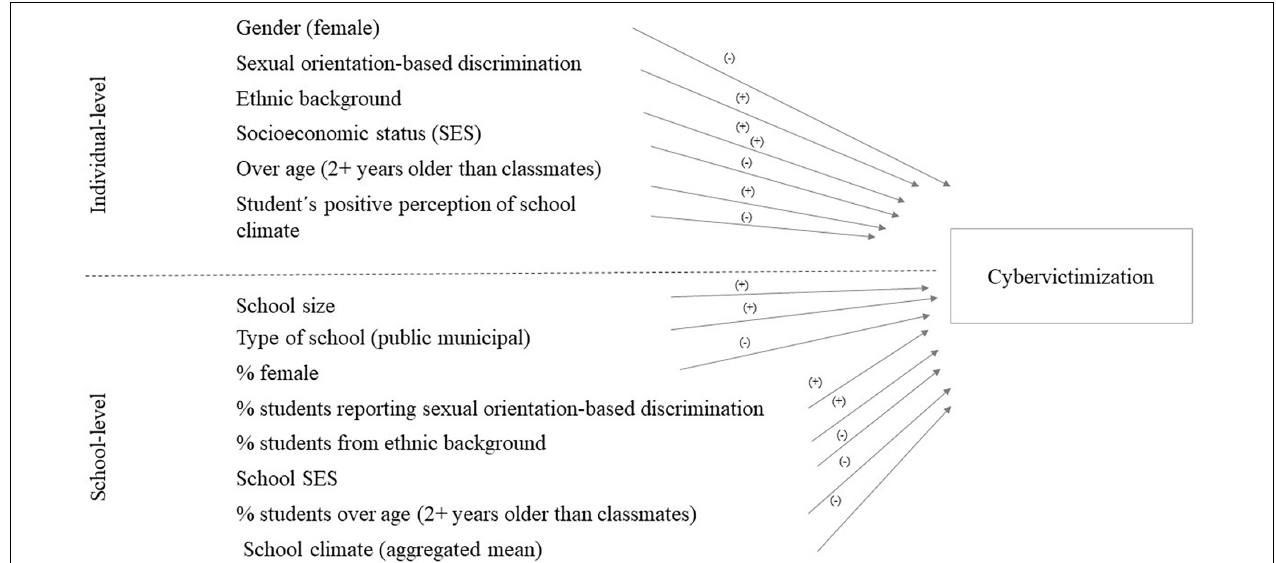
FIGURE 1 | Theoretical